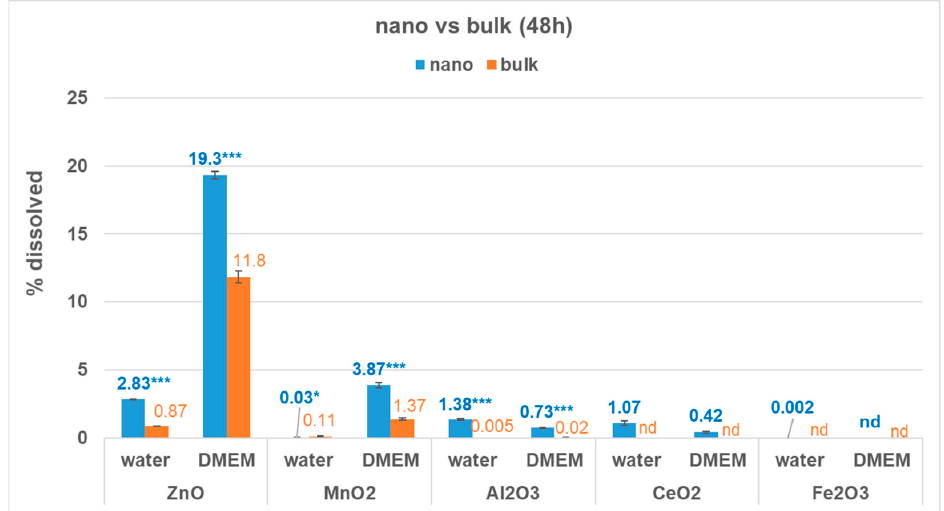
Figure 1. Influence of particle size (nano vs. bulk) on % solubility of MnO 2 , ZnO, CeO 2 , Al 2 O 3 , and Fe 2 O 3 after 48 h of incubation in water and DMEM. Initial metal-oxide concentration was 100 mg/L. Results presented as mean (standard deviation) of triplicates. All pH values are reported in Tables S5A and S10, and Table S8 (Supplementary Materials) shows additional information. nd = Not detected. For a given metal-oxide and medium, ‘*’ and ‘***’ indicate significant differences between nano vs. bulk at α = 0.05 and 0.001, respectively, based on the Student’s or Welch’s t -test. Results showed that, in both media, metal-oxide ENMs were more soluble than their bulk analogues ( p < 0.001), with two exceptions. Bulk-MnO 2 was slightly more soluble in water than nano-MnO 2 ( p = 0.025), and Fe 2 O 3 was insoluble in both media regardless of particle size (nano-Fe 2 O 3 had a negligible % solubility in water, 0.002%). However, disso- lution was below 1% for both exceptions, which for grouping exercises corresponds to “negligible solubility, <1%”. In this paper, above 70% indicates high solubility, 10–70% indicates moderate solubility, 1–10% indicates low solubility, and below 1% indicates neg- ligible solubility [19].